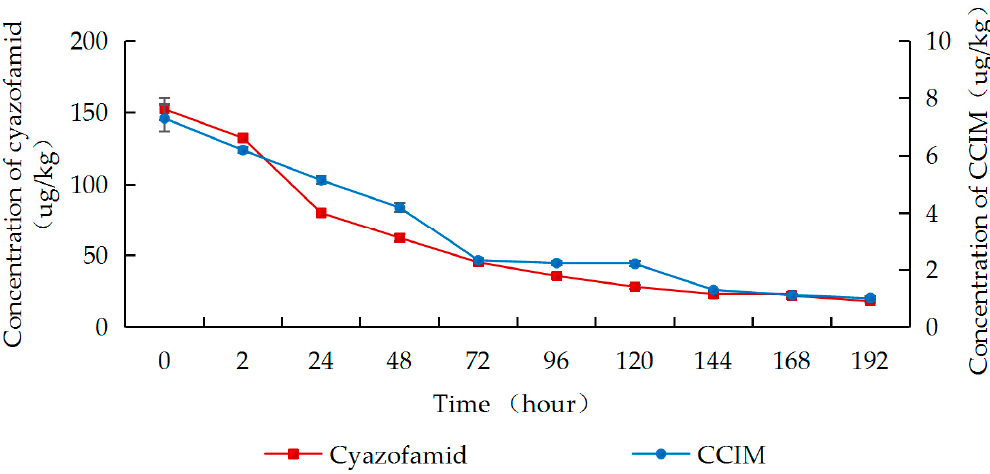
Figure 4. Concentrations of cyazofamid and CCIM in Group C during the wine-making process.